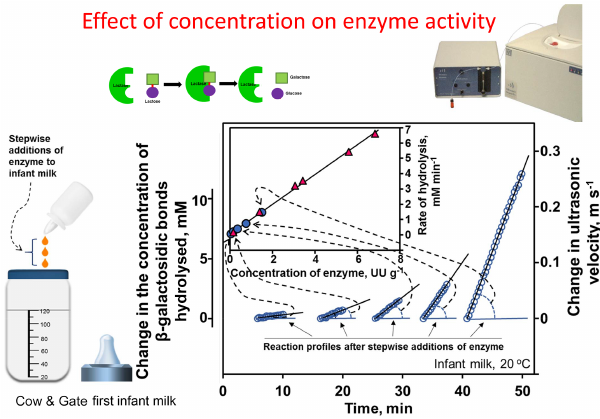
Figure 4. Ultrasonic assessment of effects of enzyme ( β - galactosidase) concentration on its activity in hydrolysis of lactose in milk. Main frame: time profiles of ultrasonic velocity and of con- centration of β -galactosidic bonds (lactose and GOS) hydrolysed in Cow & Gate First Infant Milk in automatic stepwise injections of β - galactosidase ( Kluyveromyces lactis ) at 20 ◦ C. HR-US 102PT spec- trometer equipped with HR-US titration accessory (Sonas Tech- nologies Ltd. Dublin). The ultrasonic measurements were collected in 2 to 15MHz frequency range. As no significant effects of fre- quency on the ultrasonic reaction profiles were observed, only the data at 5MHz are presented. Inset: the initial rates of hydrolysis as function of enzyme concentration; circles – calculated from the data presented in the main frame; triangles – obtained from sep- arate measurements in the samples with different concentration of the enzyme. Adapted with permission from Altas (2016). Copyright ©2016 American Chemical